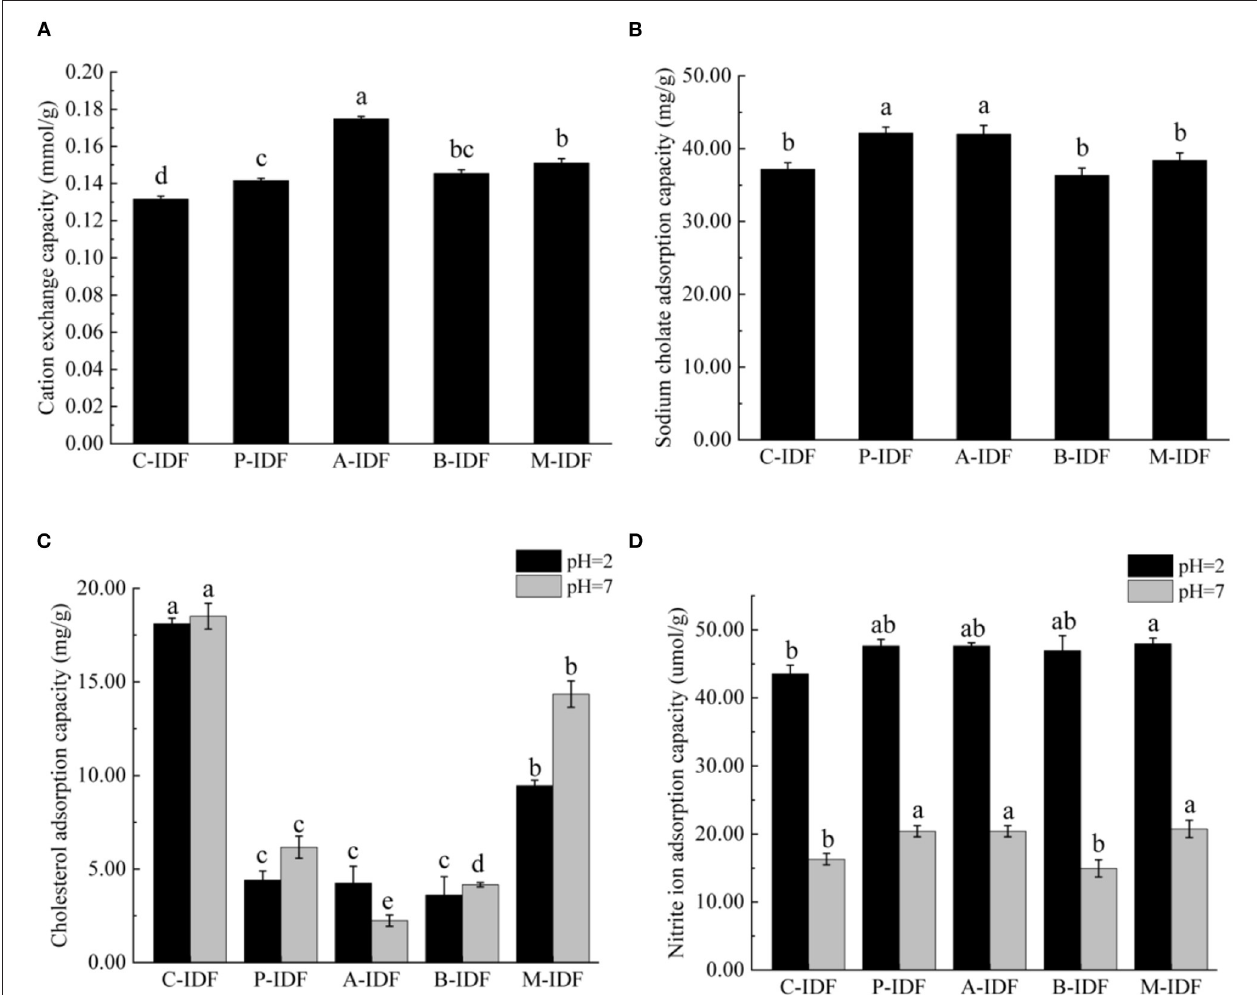
FIGURE 5 | Functional adsorption capacity of W-IDF. (A) Sodium cholate adsorption capacity (SCAC), (B) Cholesterol adsorption capacity (CAC), (C) Cation exchange capacity (CEC), (D) Nitrite ion adsorption capacity (NIAC). Data were expressed as means ± SD with different letters representing significant difference ( p < 0.05).